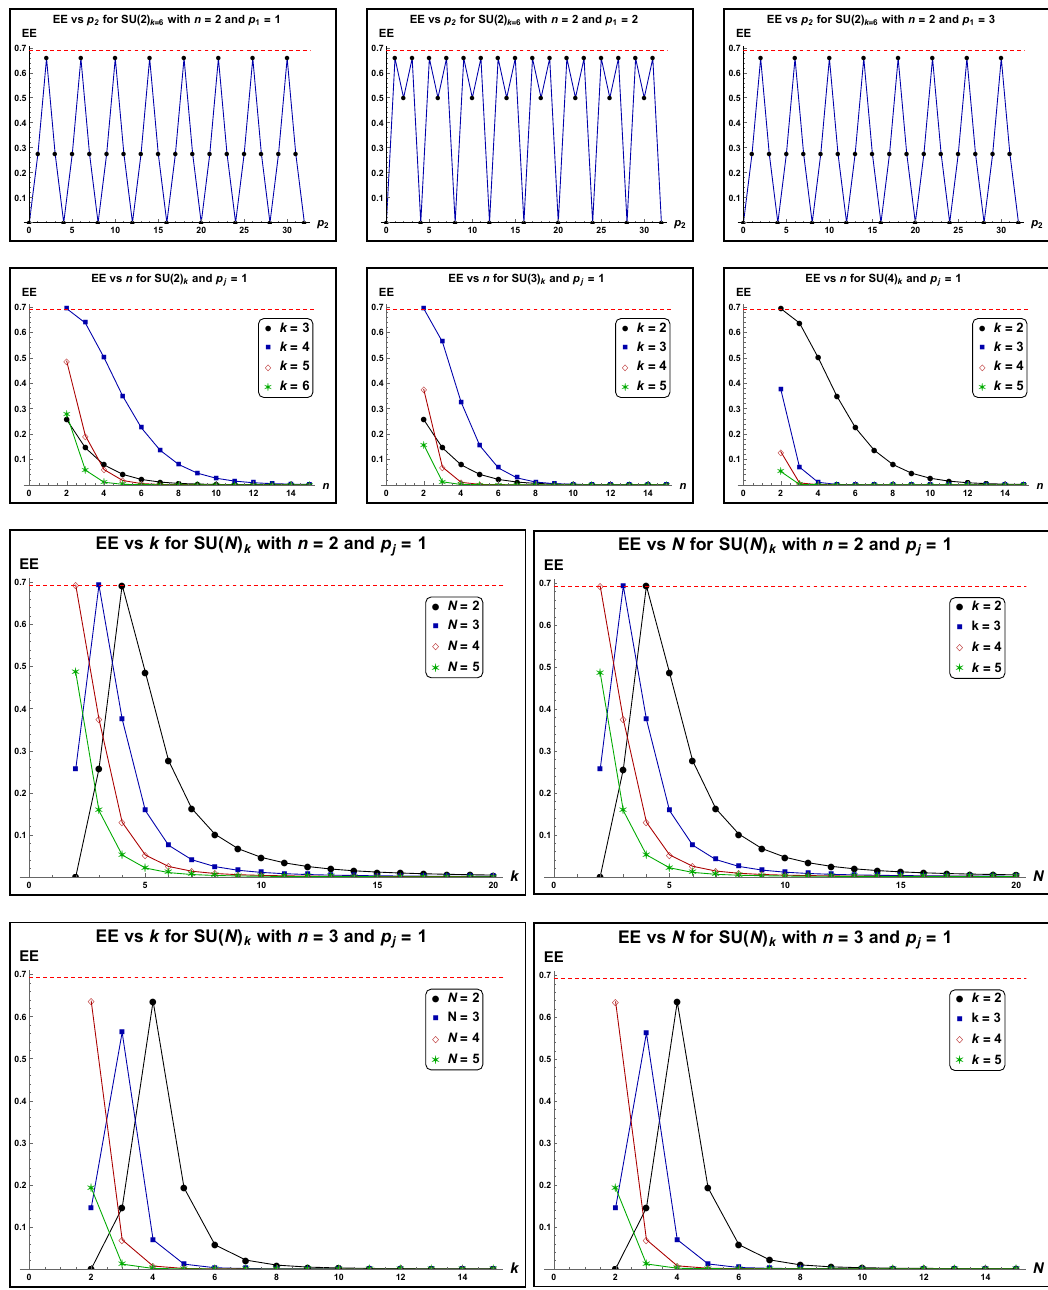
Figure 15 . Variation of SU( N ) k entropy for the state j (cid:9) mental representation. The horizontal dotted line represents the maximum value (ln 2) of